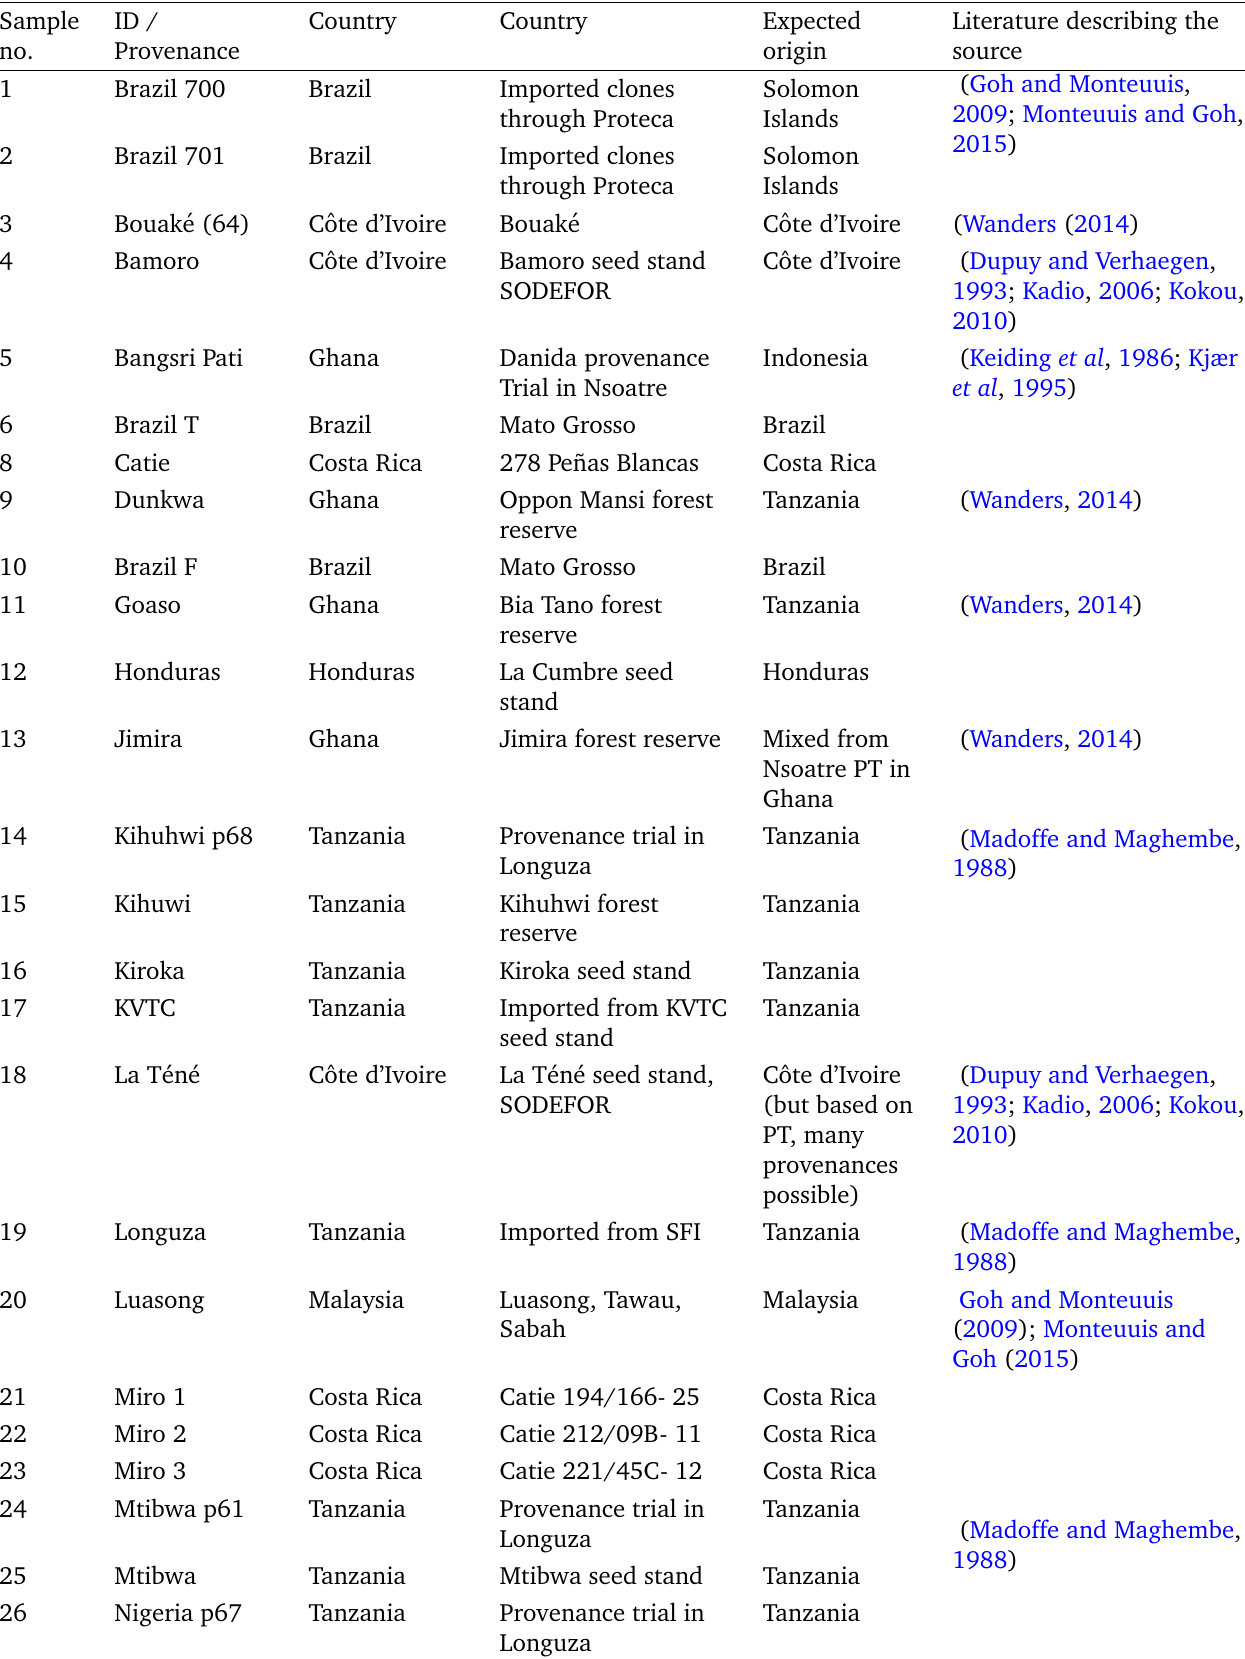
Table 1. Analysed provenances, ID and their origin in this